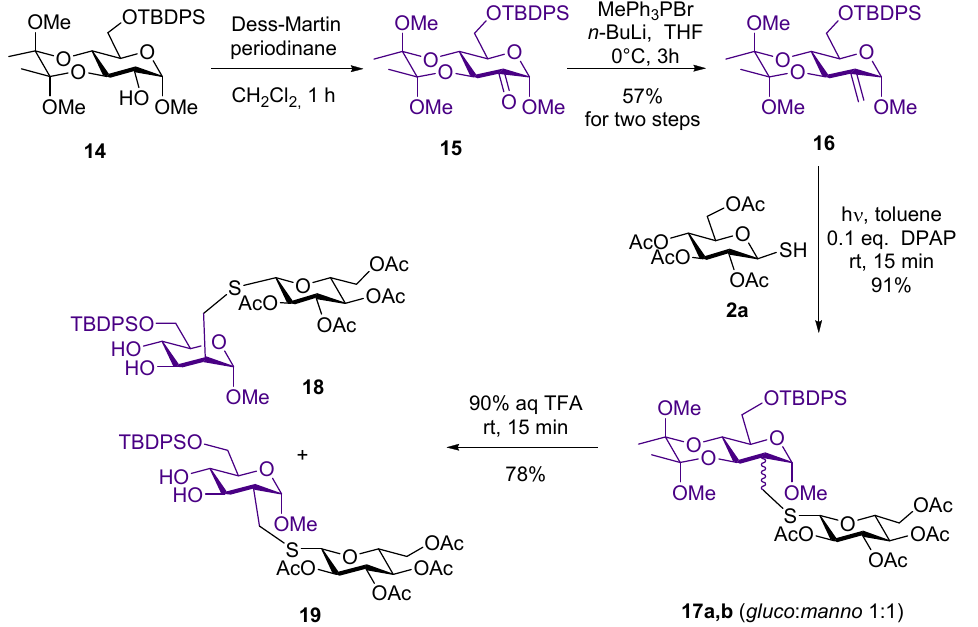
Figure 1. Stereoselective synthesis of glycosylmethyl sulfide type glycomimetics by thiol-ene reactions of exo -glucal 10 .